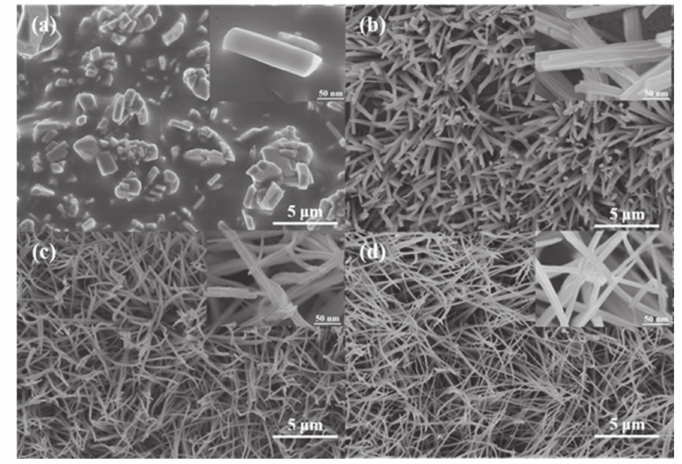
Figure 1. FESEM images of the samples prepared at room temperature with di ff erent current density, ( a ) 10, ( b ) 15, ( c ) 20, and ( d ) 25 mA cm − 2